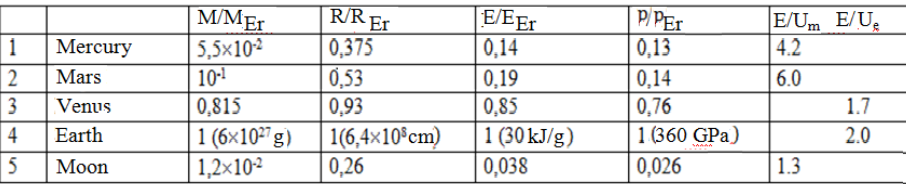
Fig.1. Specific gravitational energy W of the planets related to the Earth is shown as function of their mass M . The bodies are divided into three classes: I, II and III. Table 1. Planets parameters